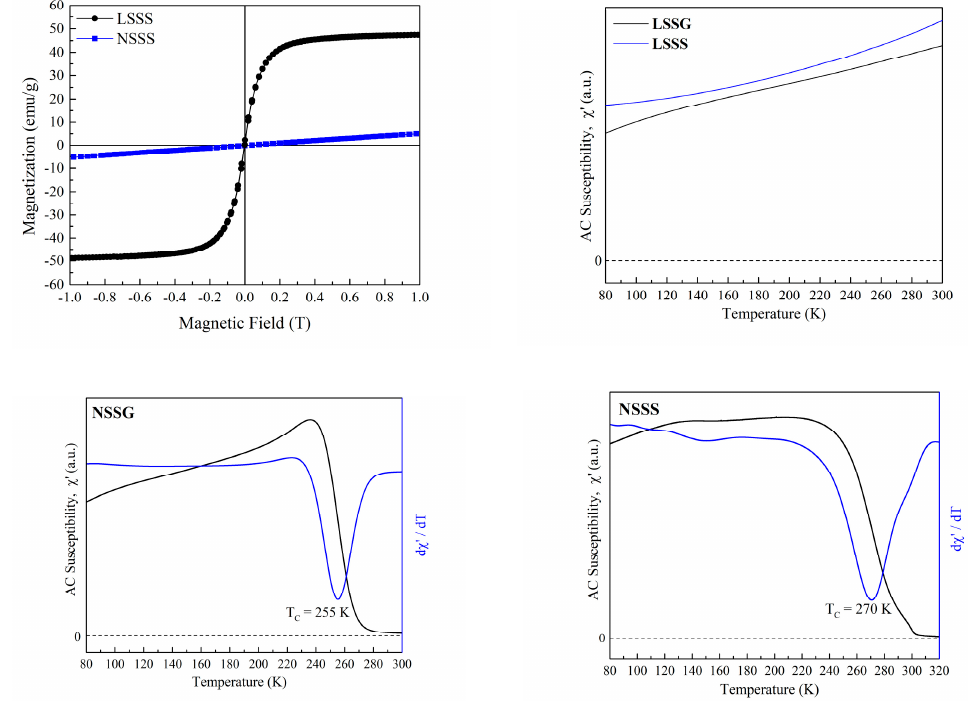
Figure 4. VSM measurement at room temperature and temperature dependence of AC susceptibility for LSMO and NSMO compounds.